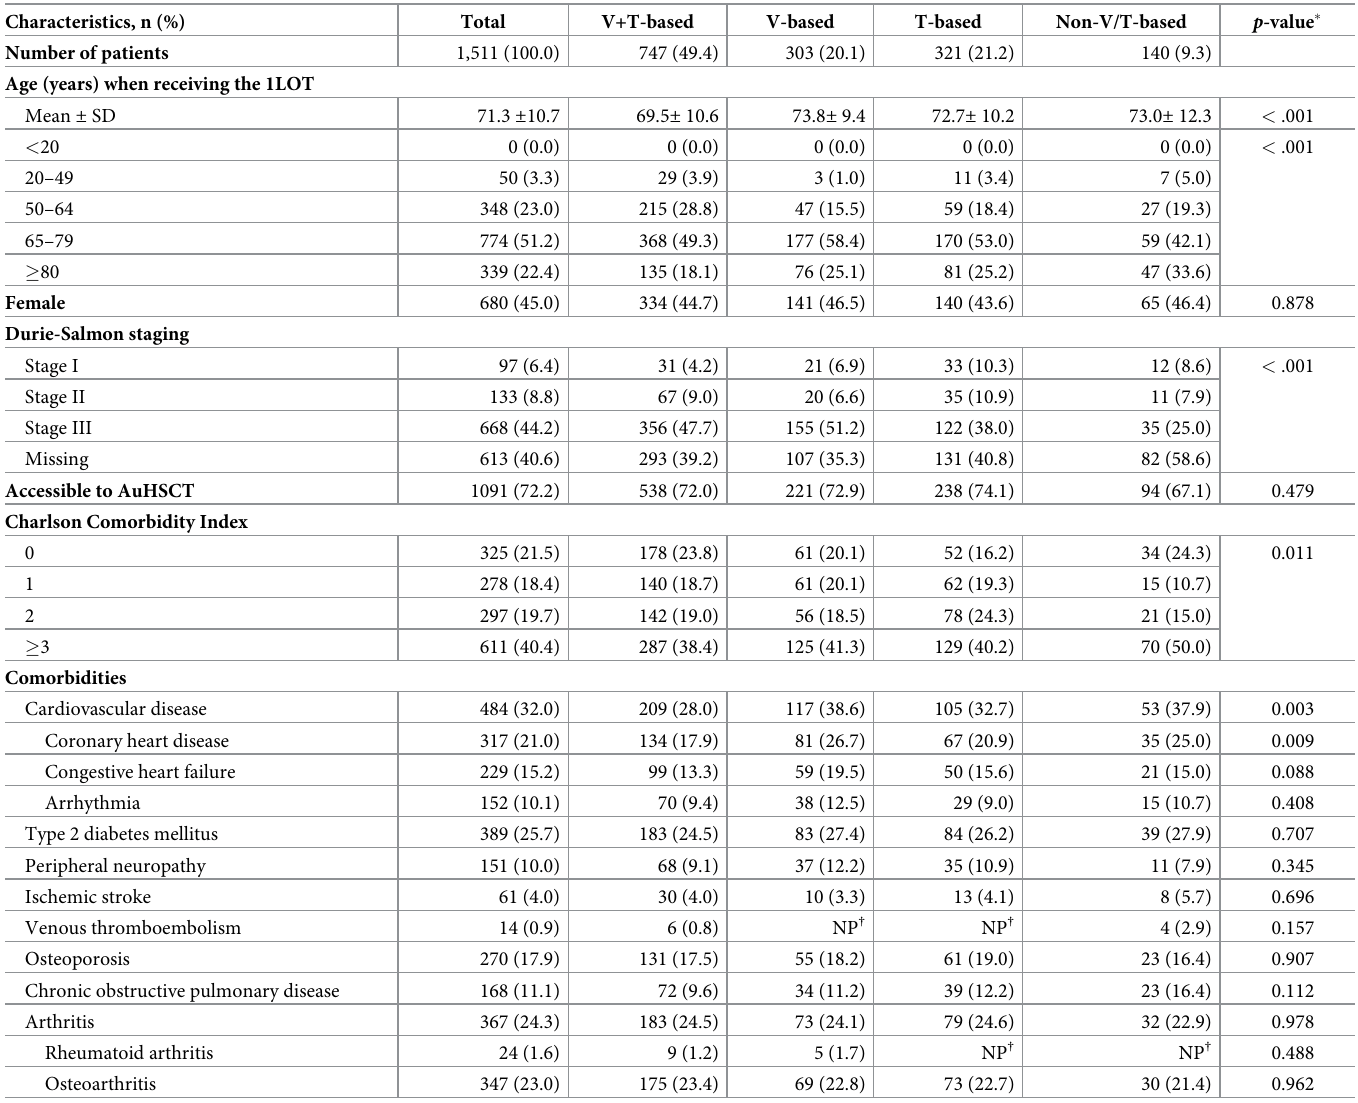
Table 1. Baseline patient